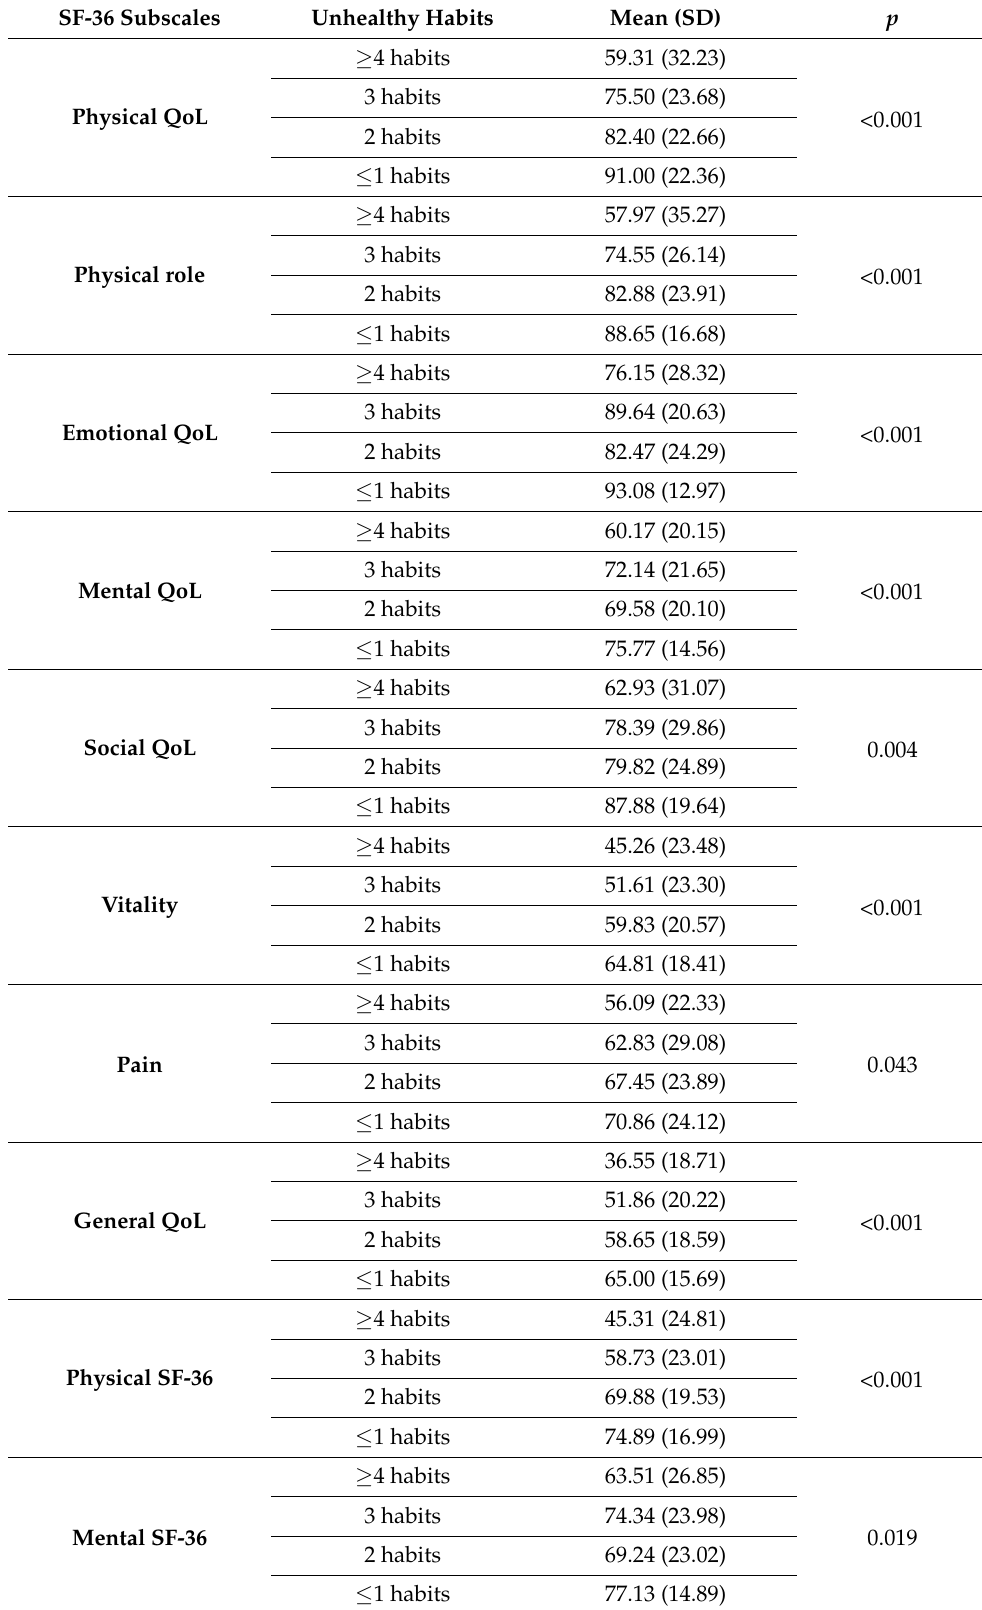
Table 2. Univariate association of aggregate habits and QoL SF-36